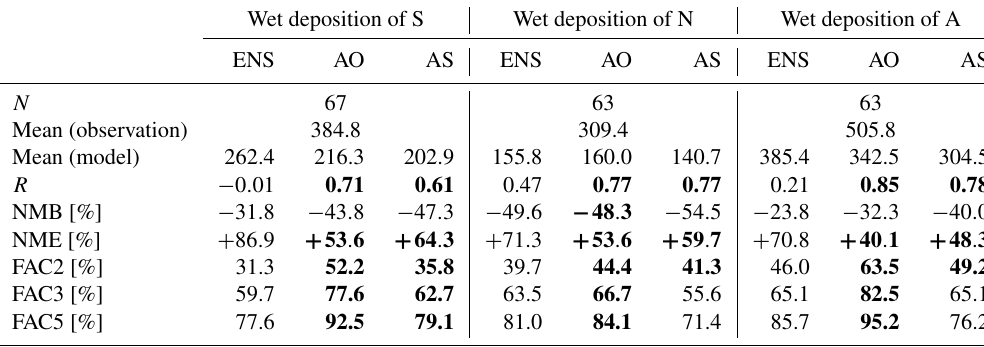
Fig. 4. The wet season (monthly accumulated precipitation more than 50 mm) lasted from March to November.